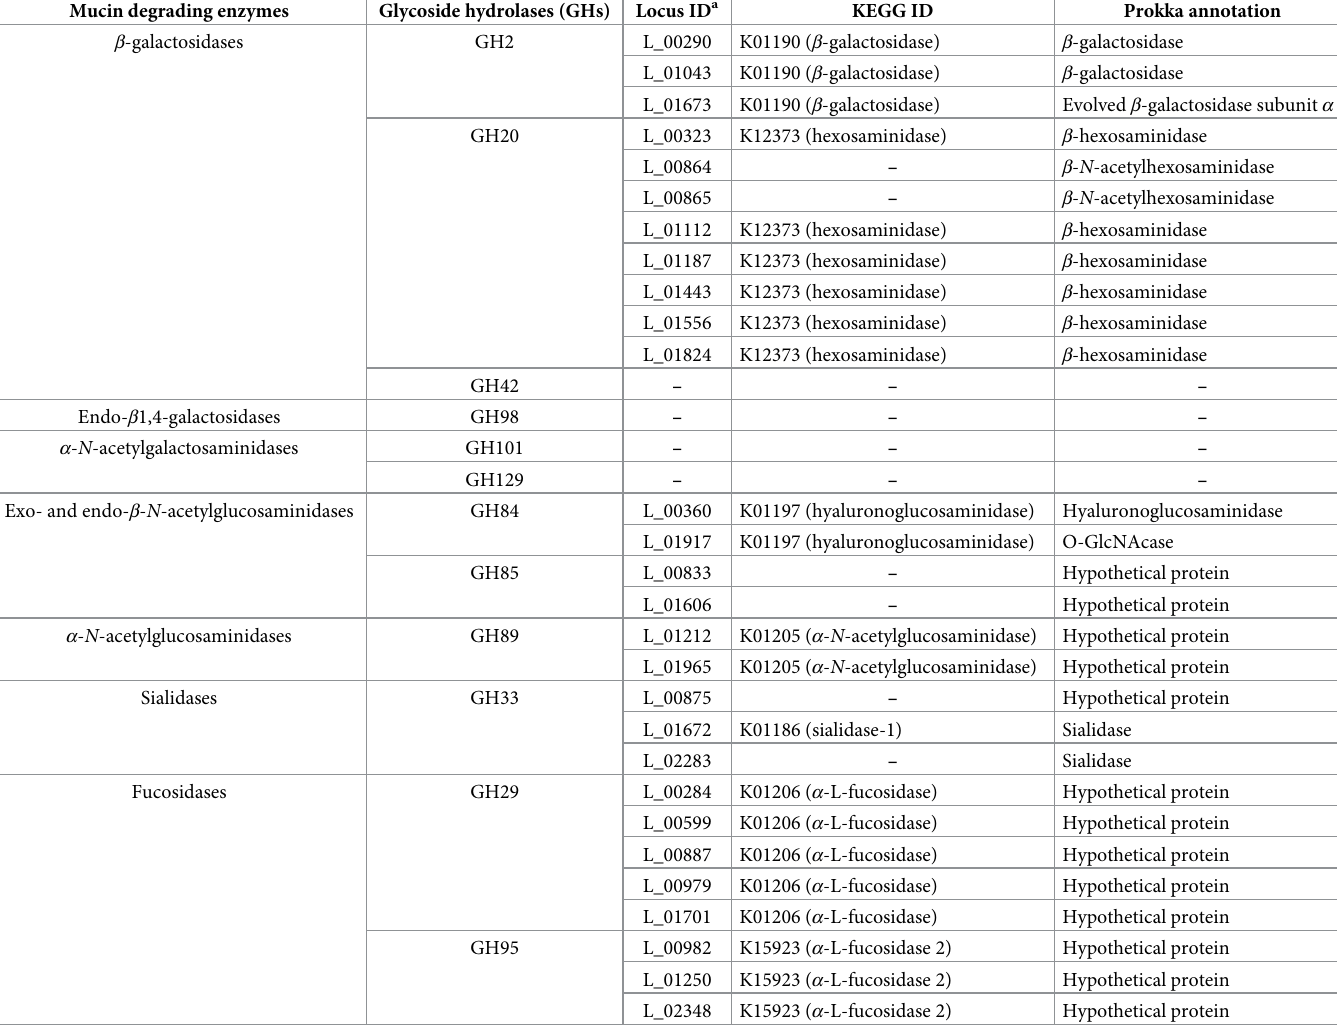
Table 5. List of predicted mucin degrading enzymes in the complete genome of strain E39 T